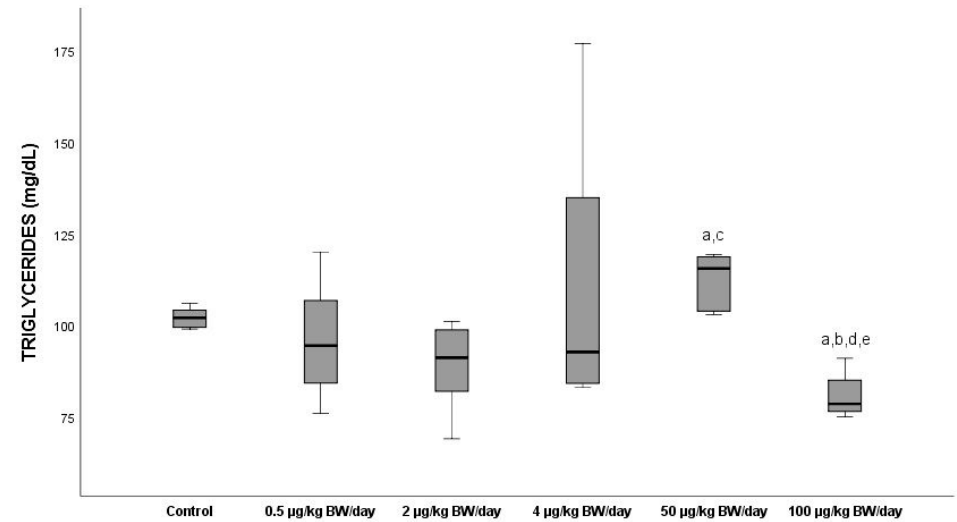
Figure 2. Means ± standard deviations of the serum levels of triglycerides (TG) expressed in mg/dL in the different exposure groups. a significant differences vs. control (G0) ( p < 0.05); b significant differences vs. 0.5 µg/kg BW/day (G1); c significant differences vs. 2 µg/kg BW/day (G2); d significant differences vs. 4 µg/kg BW/day (G3); e significant differences vs. 50 µg/kg BW/day (G4).